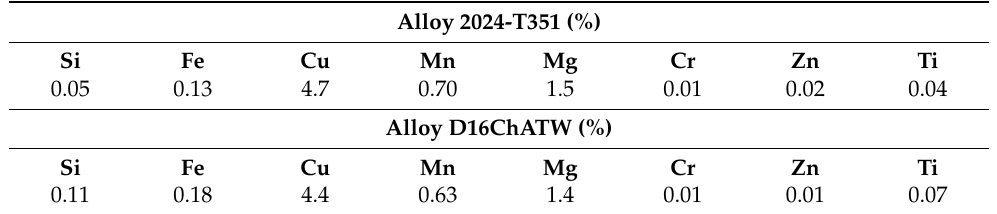
Table 2. Chemical composition of the aluminum alloys